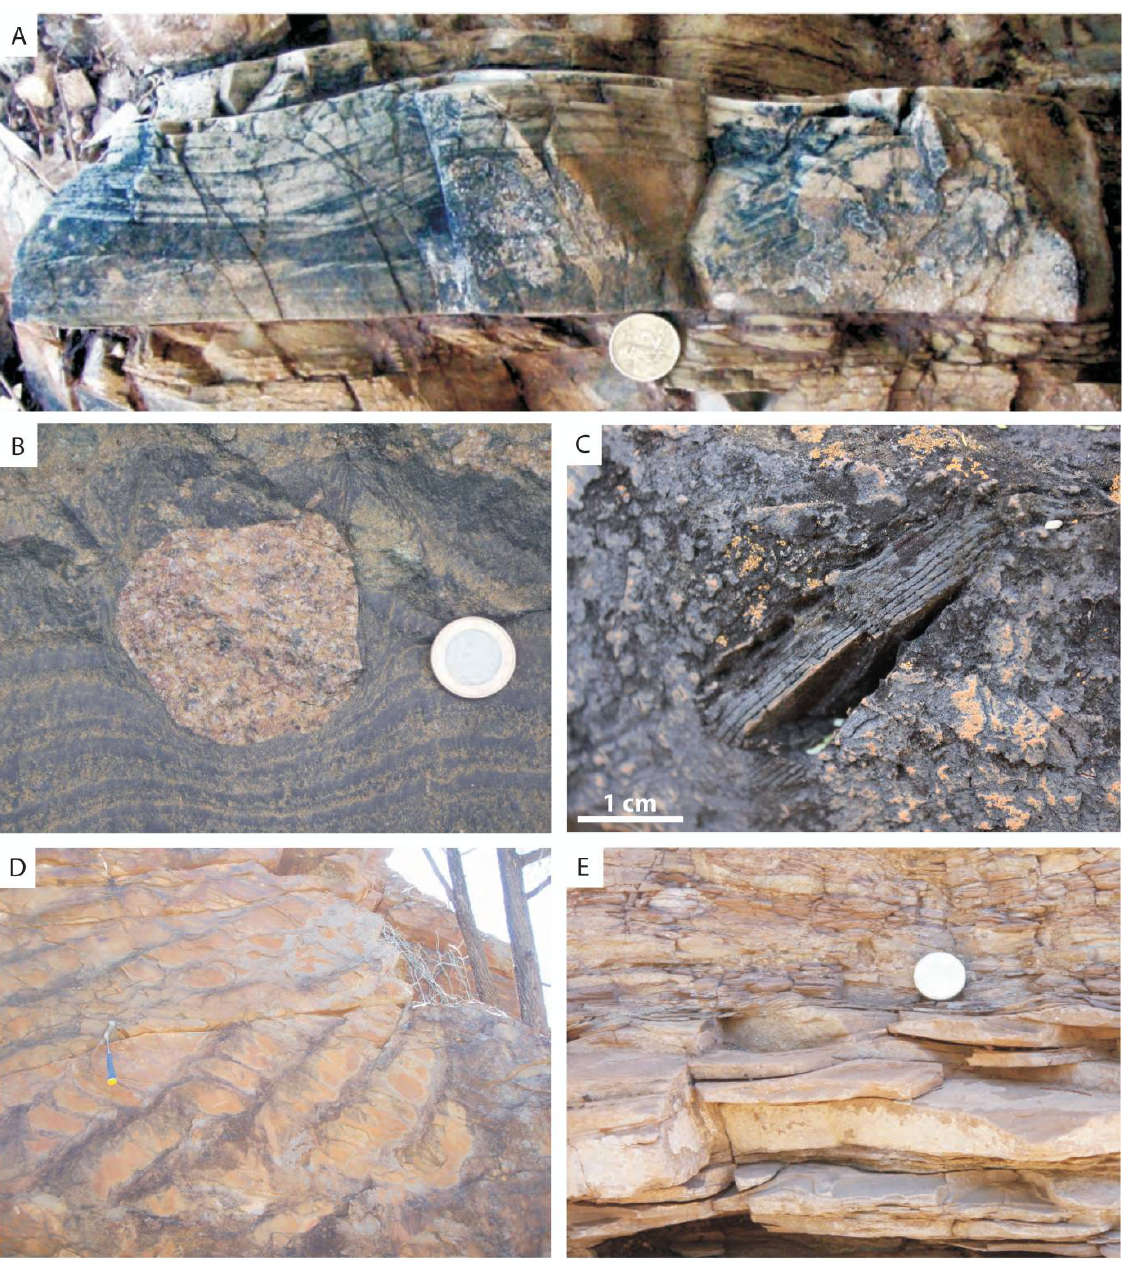
Figure 4. Sedimentary features that illustrate ice-free or discontinuous ice conditions in Cryogenian glacial successions. ( A ) Hummocky cross stratification in sandstones of the Wilyerpa Formation, central Flinders Ranges, Australia; ( B ) Granite lonestone, interpreted as an ice-rafted dropstone, in the Bebedouro Formation of the Chapada Diamantina, Brazil; ( C ) Microbial laminate-bearing ironstone within the Chuos Formation, Ghaub Farm, Otavi Mountainland of Namibia; ( D ) Ladderback ripples on a dipping sandstone surface in the Elatina Formation, Warren Gorge, South Australia; ( E ) Wave ripples in sandstone in cross section, immediately above the basal diamictite of the Elatina Formation, Bulls Run, central Flinders Ranges, Australia. All photos by D. Le Heron; photo A is taken from